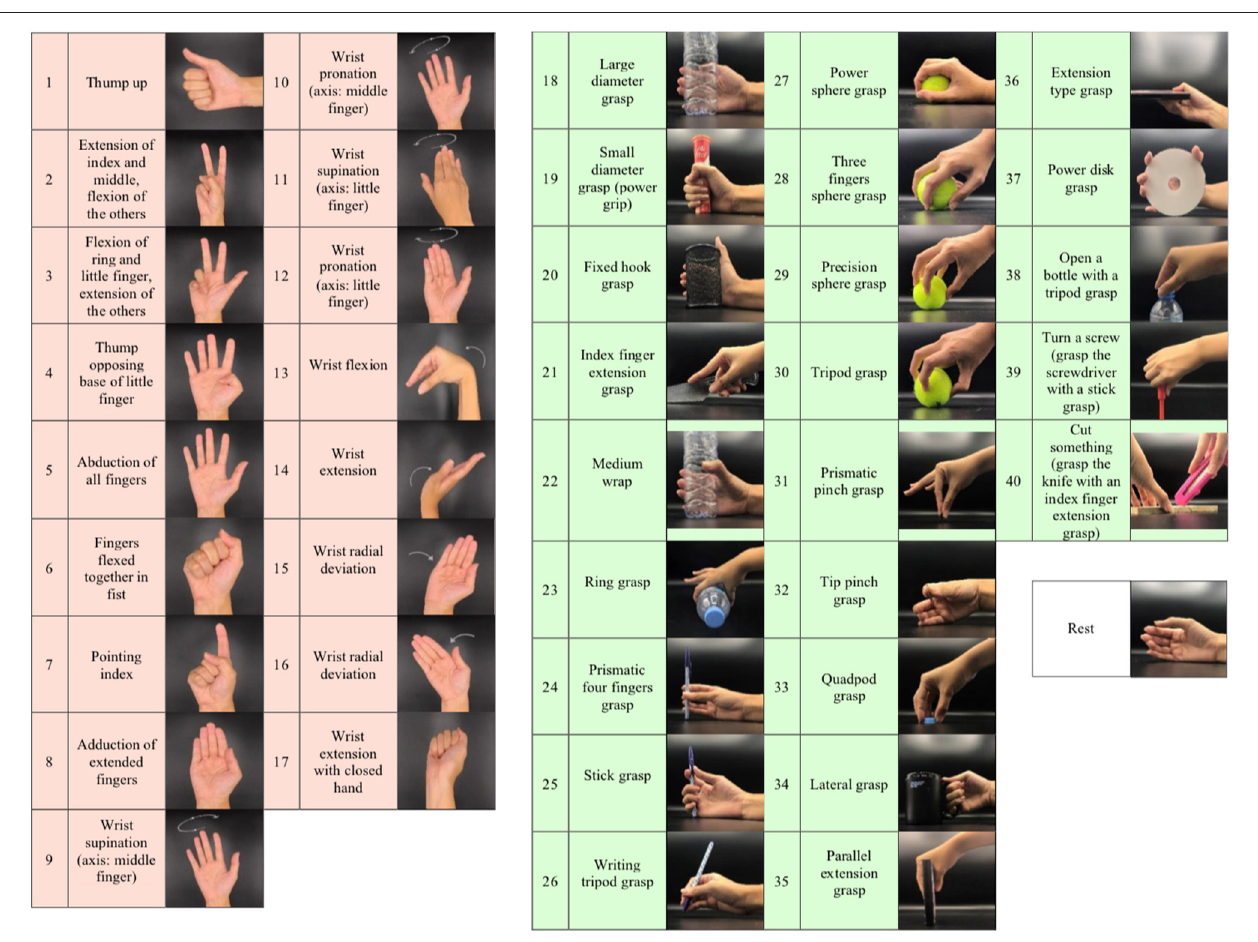
FIGURE 2 | Illustration of the 41 movements in this study according to the grouping from the Ninapro project: isometric and isotonic hand configurations and basic wrist movements (17 exercises), grasping and functional movements (23 exercises), and rest position.